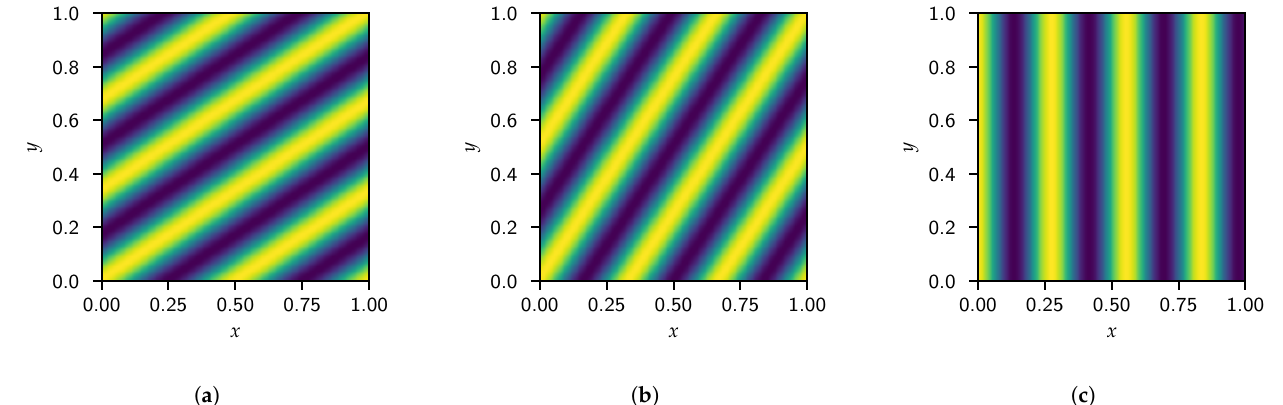
Figure 4. The real component of the complex exponential weighting of the FFTs at f ef f = 5 for ( a